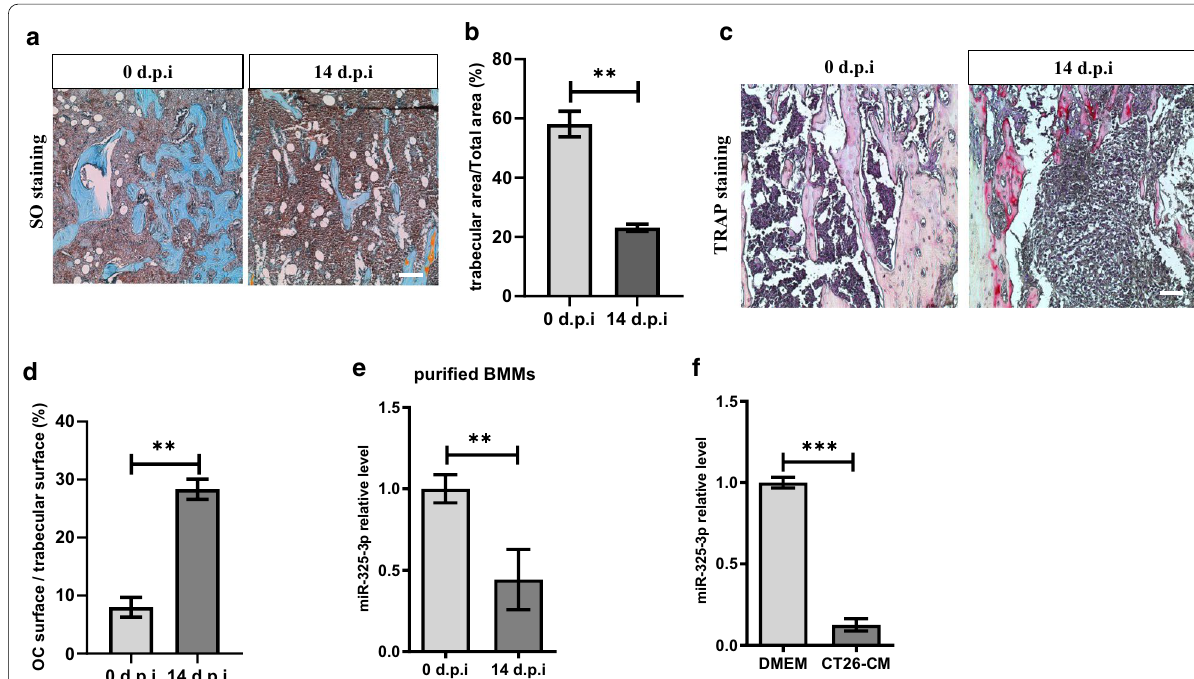
Fig. 1 miR-325-3p downregulates in osteoclast precursors in bone metastasis of CRC. a 100,000 CT-26 cells were injected into tibias in mice and the samples were collected at specific timepoints to be sectioned. Safranin O-Fast Green staining revealed trabecular area (Scar bar mice). b Quantification of trabecular area in (a) (mean SE). c TRAP staining revealed TRAP positive cells in trabecular area at specific timepoints ± after injection of CT-26 cells (Scar bar 50 μm) (n 3 mice). d Quantification of relative area of osteoclast surface in ( c ) (mean = = were isolated from bone marrow at specific timepoints through FACS. Real-time PCR analysis showed the relative expression of miR-325-3p in OCPs at 14 d.p.i comparing with OCPs at 0 d.p.i. (D0, n 3 mice; D14, n 5 mice) (mean SD). f. Primary OCPs were isolated and cultured in DMEM or = = ± CT-26 CM for 4 days in the presence of RANKL and M-CSF. Real-time PCR analysis showed the relative expression of miR-325-3p in OCPs treated by CM or DMEM (mean SD). In vitro experiments were performed at least 3 times. *p < 0.05, **p < 0.01, ***p < ±